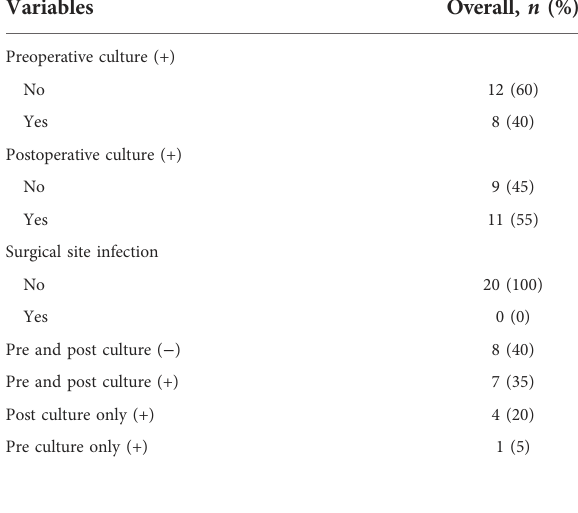
TABLE 2 Preoperative and postoperative culture results.